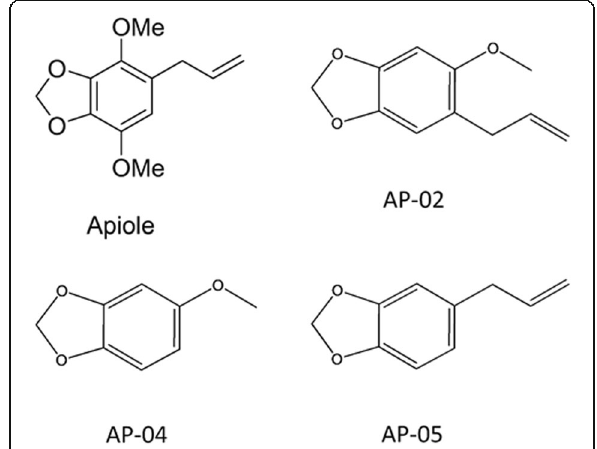
Fig. 2 Chemical structures of apiole derivatives (AP-02, AP-04 and